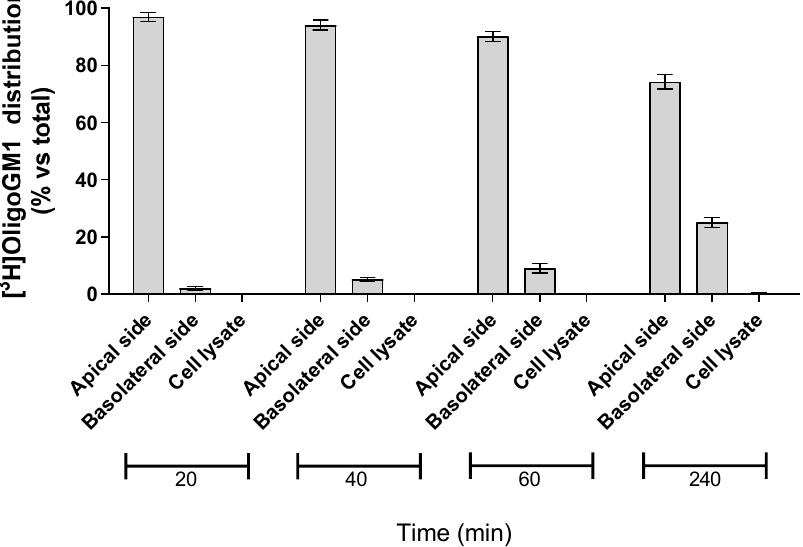
Figure 4. Association of [ 3 H]OligoGM1 to hBLECs. Direct transport experiment (A → B) was performed as reported in the Methods section by adding 50 µ M [ 3 H]OligoGM1 to the apical compartment. After 20, 40, 60, and 240 min, the solutions from apical and basolateral sides were collected and hBLECs were treated to obtain the cell lysate. The radioactivity associated with each fraction was determined by liquid scintillation counting. Data are expressed as percentage mean of total radioactivity ± SEM of three di ff erent experiments ( n = 3).